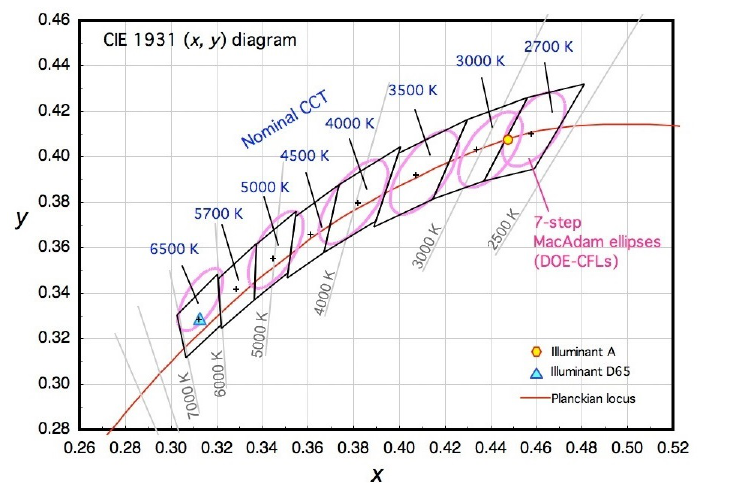
Figure 2. Graphical representation of the chromaticity tolerance regions of LED products on the CIE 1931 chromaticity